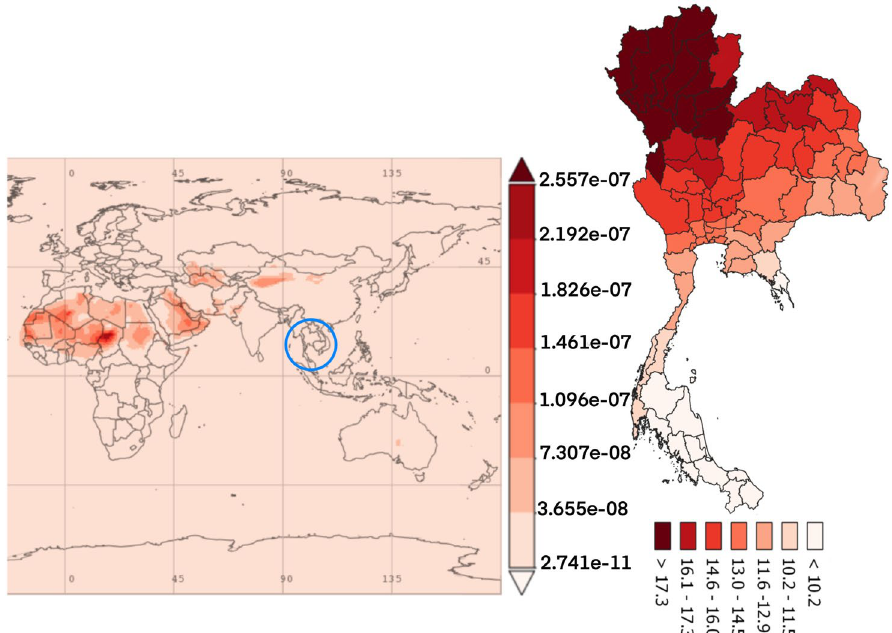
Figure 5. The average time of dust PM 2.5 concentration monthly over 2010–2016. (The world map was generated by Giovanni Version 4.34: a free and open source earth data, https ://giova nni.gsfc.nasa.gov/giova nni/) and accumulated dose between 2010 and 2016 in Thailand (Thailand map was generated by QGIS software: a free and open source geographic information system, https